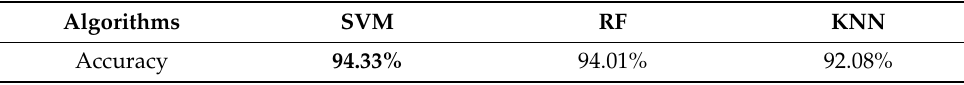
Table 5. Classification Accuracy of Machine